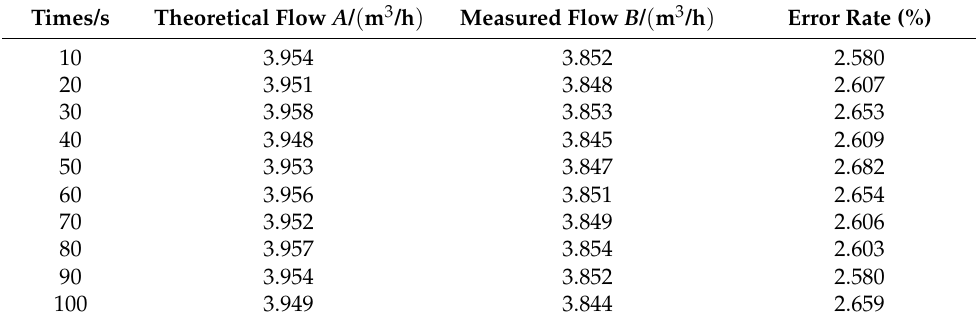
Table 2. Test results collection.